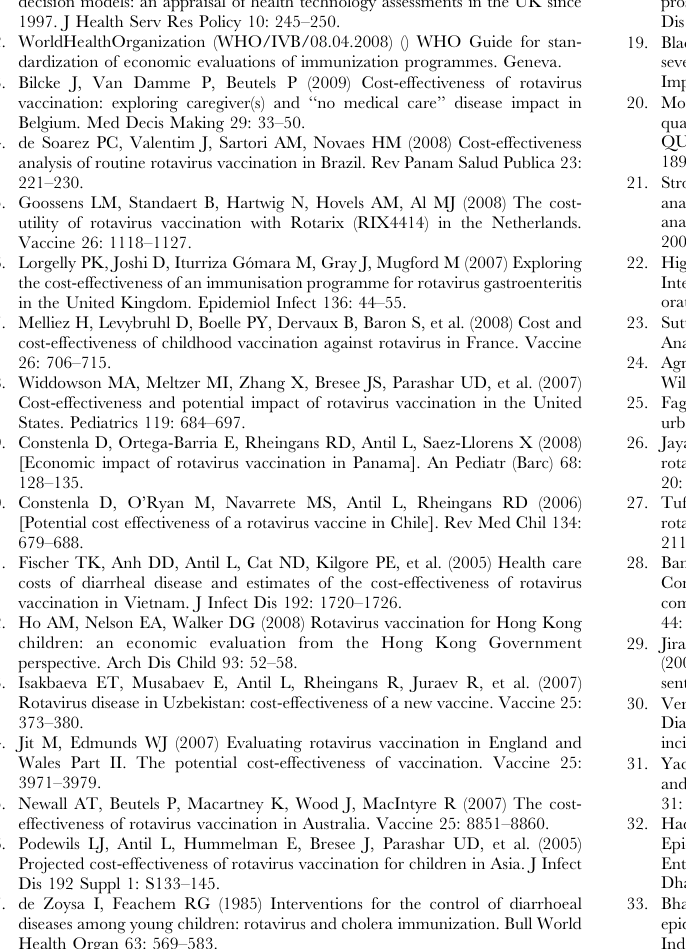
Table S1 Tool for assessing risk of bias in each of the papers included in meta-analysis.